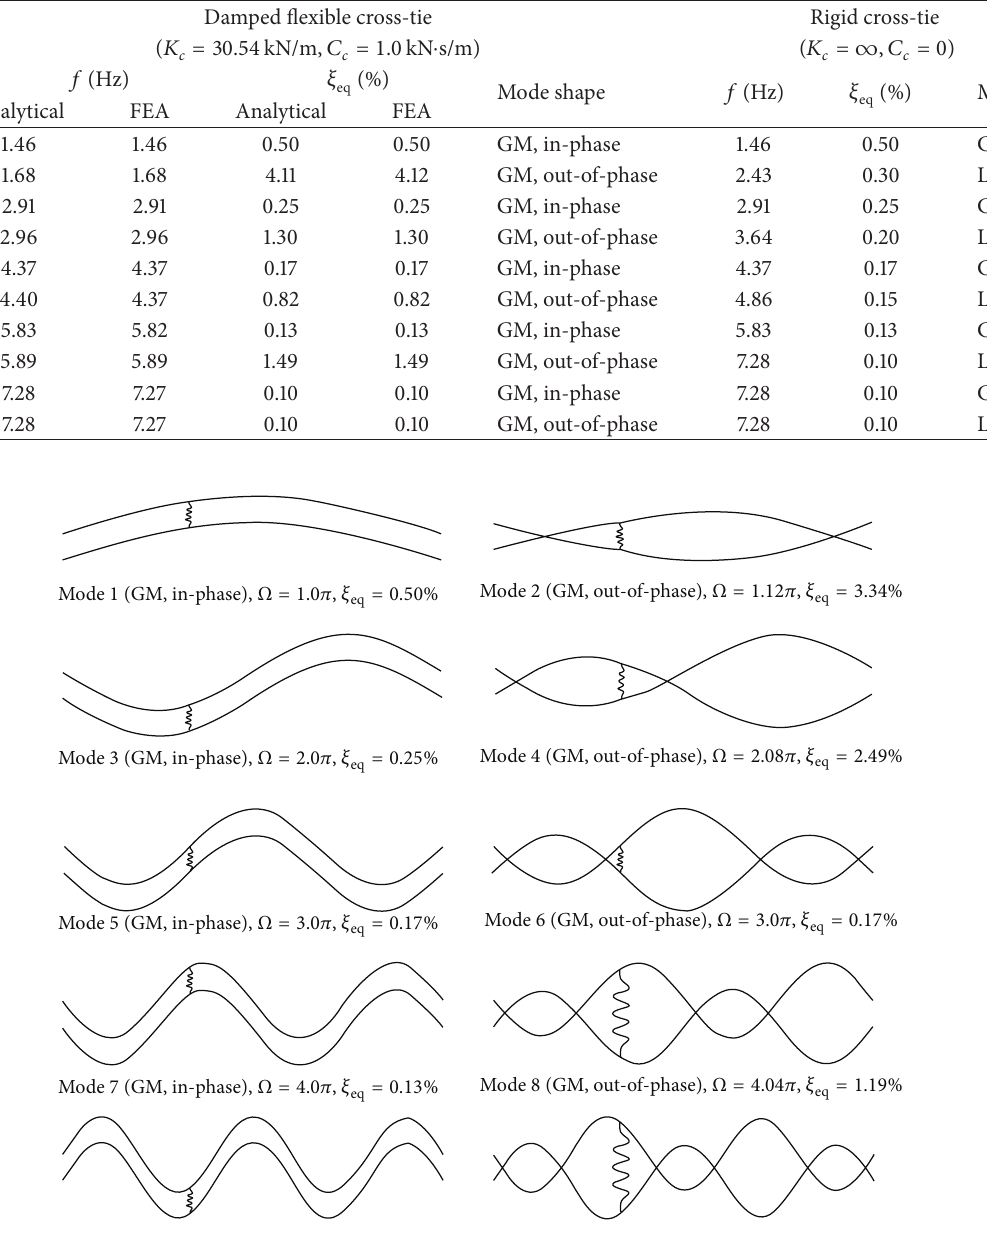
When using a rigid cross-tie network as a reference base, by 0.33% to 4.11%, and the oscillation extends from the right increasing cross-tie flexibility and damping, modal frequency segments to the entire network. The same phenomenon can of local RS modes decreases whereas modal damping ratio be observed in Mode 6 and Mode 8. In the case of Mode 4 increases. In addition, their mode shapes evolve to out-of- and Mode 10, both of which are local LS modes in the rigid phase global modes. Take Mode 2 as an example, when cross-tie network, a cross-tie position of 𝜀 = 2/5 is off the replacing the rigid cross-tie by a flexible damped one with nodal point of the 1st antisymmetric mode of an isolated cable = 30.54 kN/m and 𝐶 = 1.0 kN ⋅ s/m, its frequency 𝐾 in Mode 4, but it happens to be the nodal point of the 3rd 𝑐 𝑐 drops from 2.43 Hz to 1.68 Hz by 31%, but the associated symmetric mode of an isolated cable in Mode 10. Thus, for modal damping ratio increases approximately 12.5 times from Mode 4, the change in cross-tie properties would not